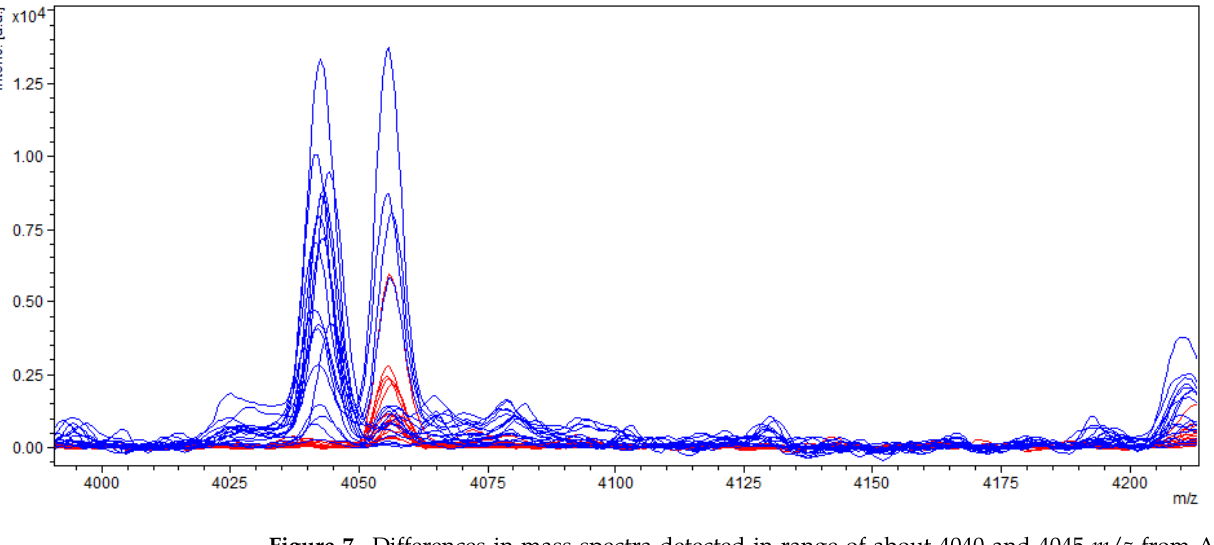
Figure 7. Differences in mass spectra detected in range of about 4040 and 4045 m/z from AFB 1 producing and non-producing strain of A. flavus , where blue spectra showed non-producers and red spectra producers.